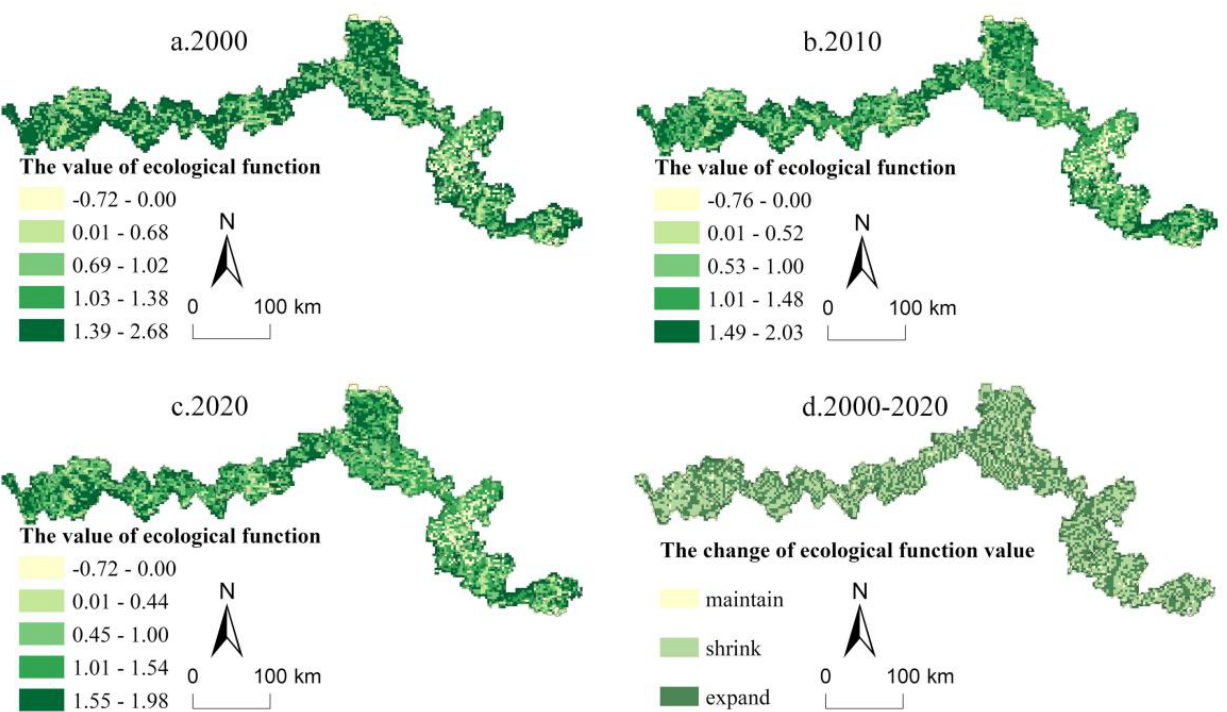
Figure 4. Ecological function value in the Sino–Vietnamese border region in ( a ) 2000, ( b ) 2010, ( c ) 2020 and ( d ) the change between 2000 and 2020.